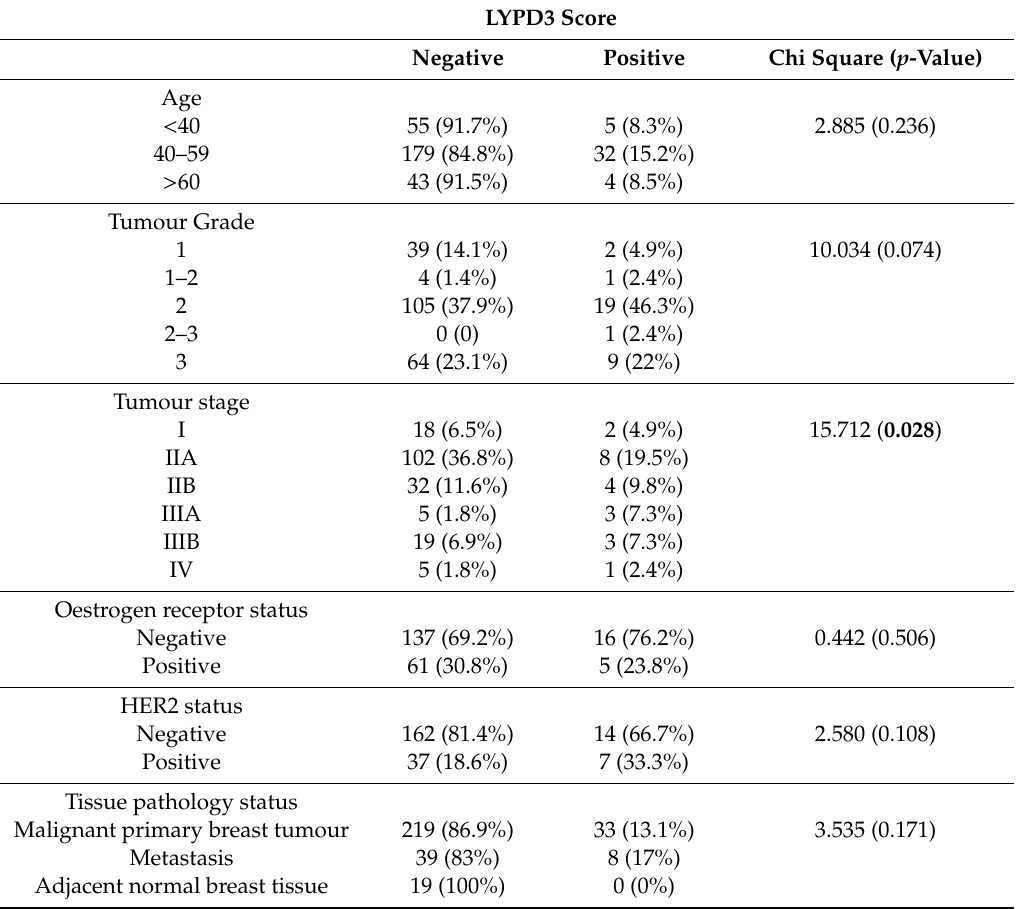
Table 3. Clinical details of cases histologically assessed for LYPD3 protein expression was compared in malignant (primary and metastatic) breast adenocarcinoma